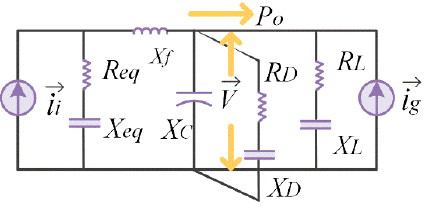
Figure 4. The equivalent circuit of the IIDG system .